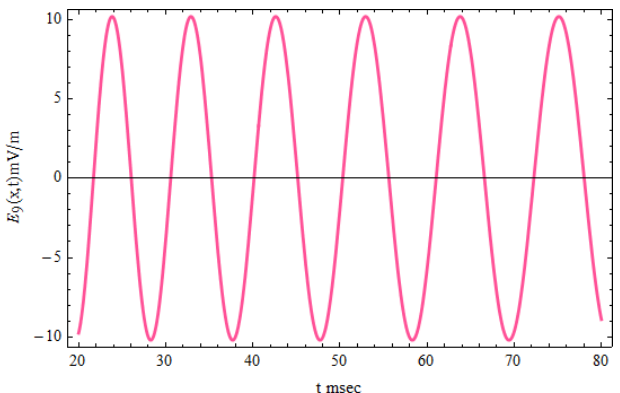
Figure 6. Variation of solution (21) versus x and ς .